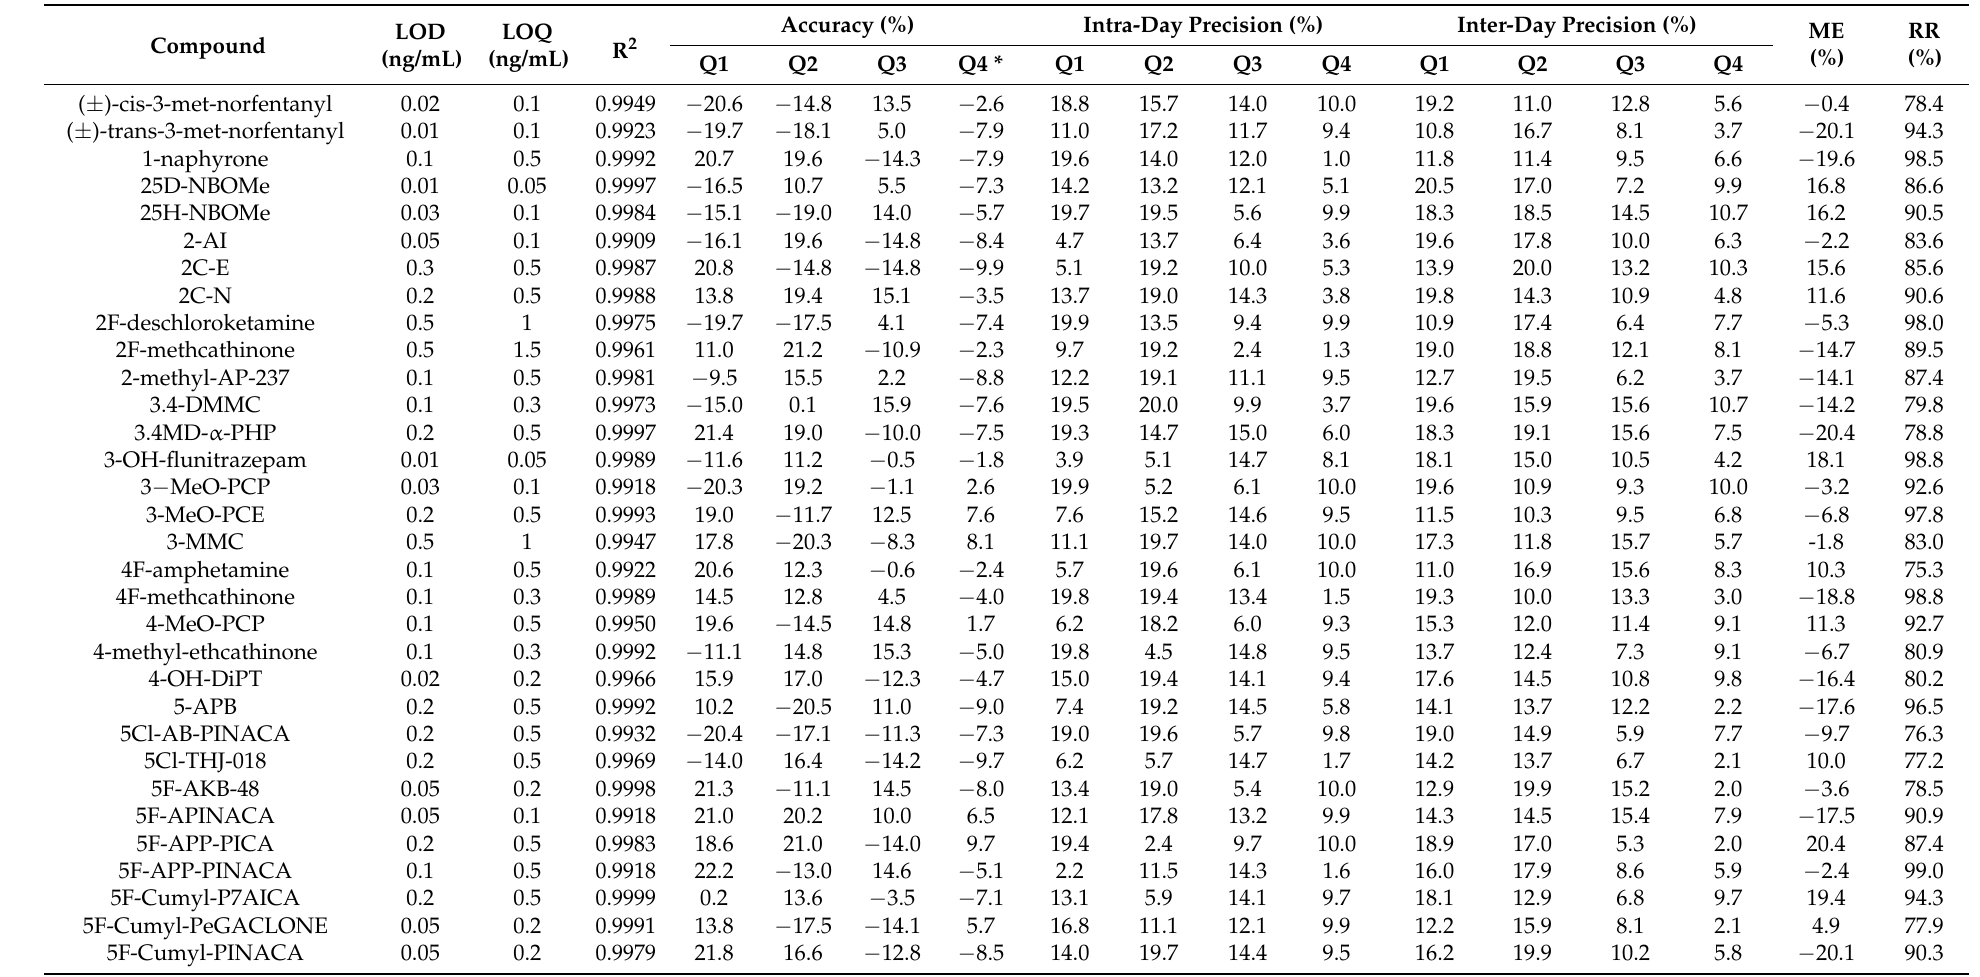
Table 2. Main validation parameters for each compound included in the screening method. N ◦ of replicates: 3 for LOD, LOQ, ME and RR; 5 for linearity, accuracy and precisions.* 250 ng/mL except for: 5-APB, 5Cl-AB-PINACA, 5Cl-THJ-018, 5F-AKB48, 5F-APP-PICA, 5F-APP-PINACA, 5F-cumyl-PINACA, 5-MAPB, 6-APB, 6-MAPB, AB-CHMINACA, acetyl-fentanyl, ADB-FUBINACA, alfentanil, APP-FUBINACA, cumyl-PeGACLONE, MeOAc-norfentanyl, MMB2201 and ritalinic acid, 150 ng/mL; ( ± )-cis-3-methyl-fentanyl, ( ± )-trans-3-methyl-fentanyl, butyryl-norfentanyl, furanyl-norfentanyl and norfentanyl, 75